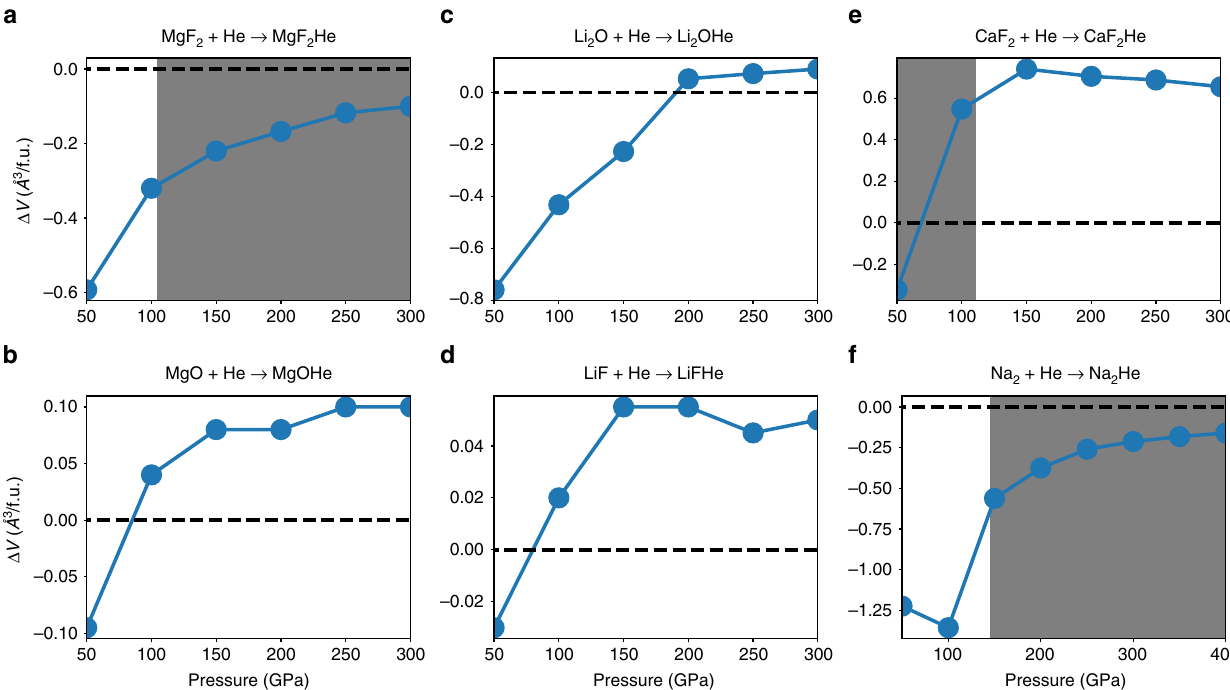
Fig. 6 The changes of the volume as a function of pressure for He insertion. a MgF 2 , b MgO, c LiF, d Li 2 O, e CaF 2 , and f Na. The dashed lines refer to a sum of the volume of the ionic compounds and elemental helium, whereas the solid line is for the ternary compound. Shaded areas present the pressure intervals of stable He